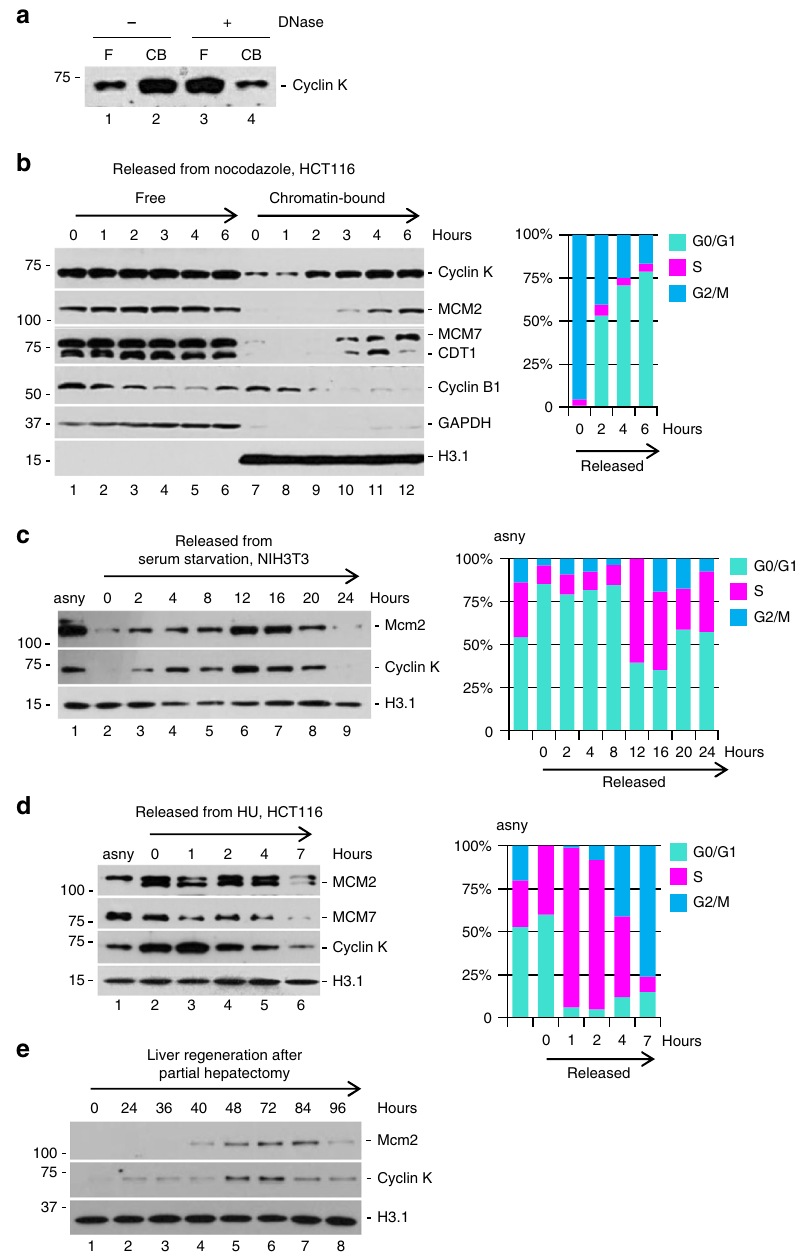
Fig. 3 Cyclin K is loaded onto chromatin in parallel with pre-RC. a Cyclin K protein level detected by immunoblotting in soluble (free) and chromatin-bound (CB) fractions with or without DNase treatment. b Loading of cyclin K and components of prereplicative complex (CDT1, MCM2, and MCM7) onto chromatin. HCT116 cells were synchronized at M phase (0 h), and then released into fresh medium. Corresponding cell cycle pro fi ling by FACS analyses was presented in right panel. c Loading of cyclin K and Mcm2 onto chromatin. NIH 3T3 cells were synchronized at G0 by serum starvation, and then released into fresh serum-containing medium. Corresponding cell cycle pro fi ling by FACS analyses was presented in the right panel. d Loading of cyclin K, MCM2, and MCM7 onto chromatin. HCT116 cells were synchronized at G1/S boundary by hydroxyurea treatment (HU, 1 mM), and then released into fresh medium. Corresponding cell cycle pro fi ling by FACS analyses was presented in right panel. e Loading of cyclin K and Mcm2 onto chromatin during the course of liver regeneration in vivo. 0 h denotes samples collected immediately after partial hepatectomy. All experiments were repeated more than three times and representative results are